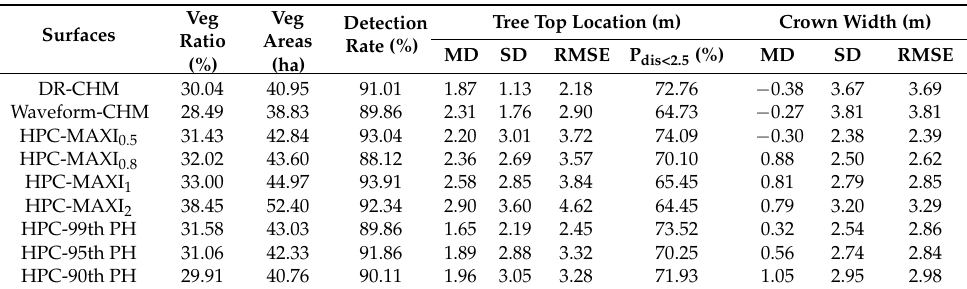
Table 2. Summary statistics of comparisons among the DR-based CHM (DR-CHM), waveform-based CHM (waveform-CHM) and the HPC-based MAXI (HPC-MAXI) and the HPC-based percentile height (HPC-PH) surfaces over the study